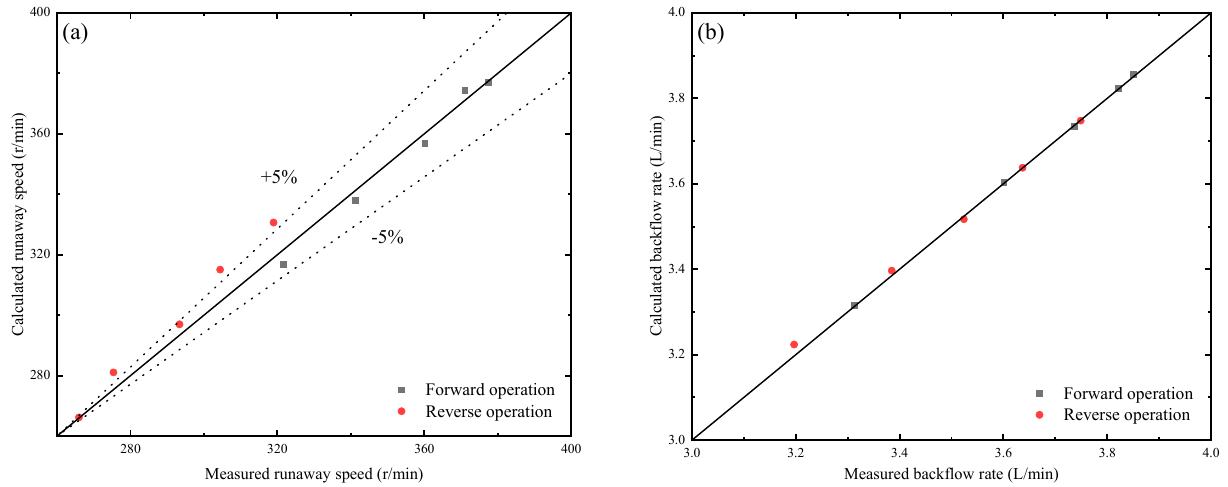
Figure 17. Comparison between measured and calculated: ( a ) unit runaway speed ( b ) unit backflow rate of the pump in forward and reverse operations.